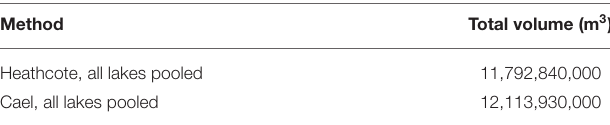
TABLE 8 | Heathcote et al. (2015) vs. Cael et al. (2017) total volume comparison for all lakes pooled.